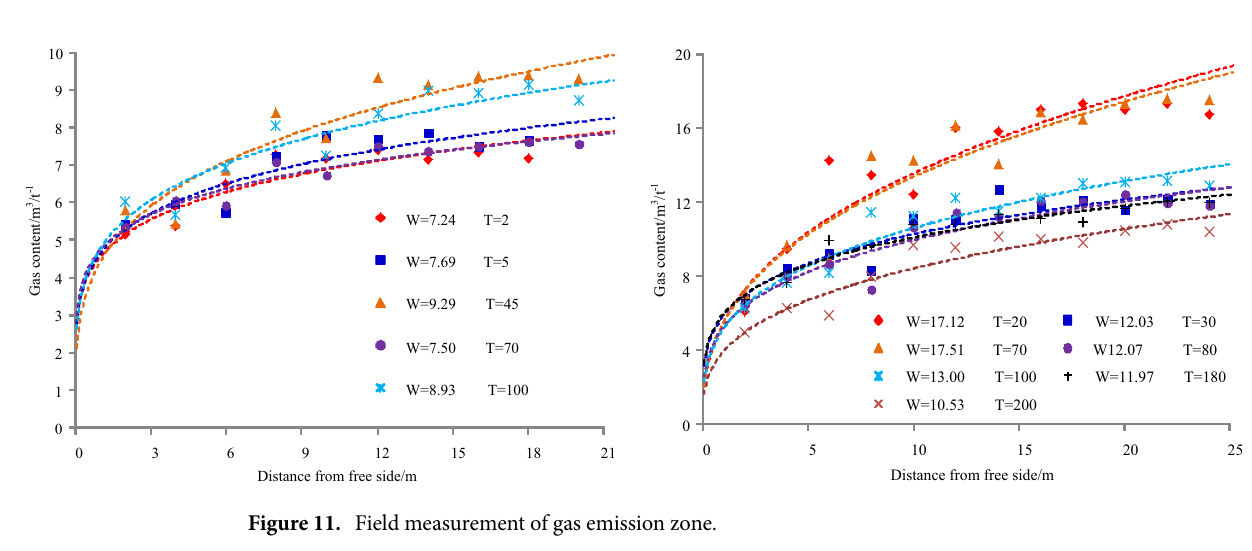
Table 5. Measured gas contents.